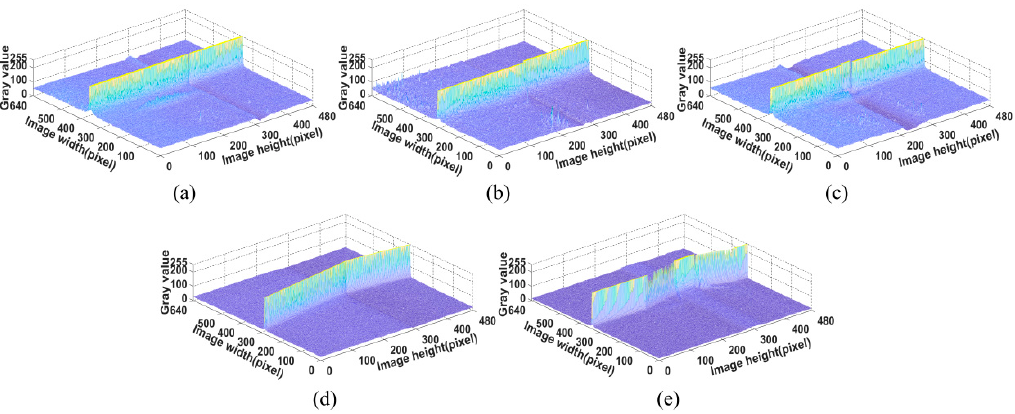
Figure 5. Grey value intensity of weld joint: ( a ) lap weld joint, ( b ) butt weld joint, ( c ) splice weld joint, ( d ) fillet weld joint, and ( e ) v-type weld joint.